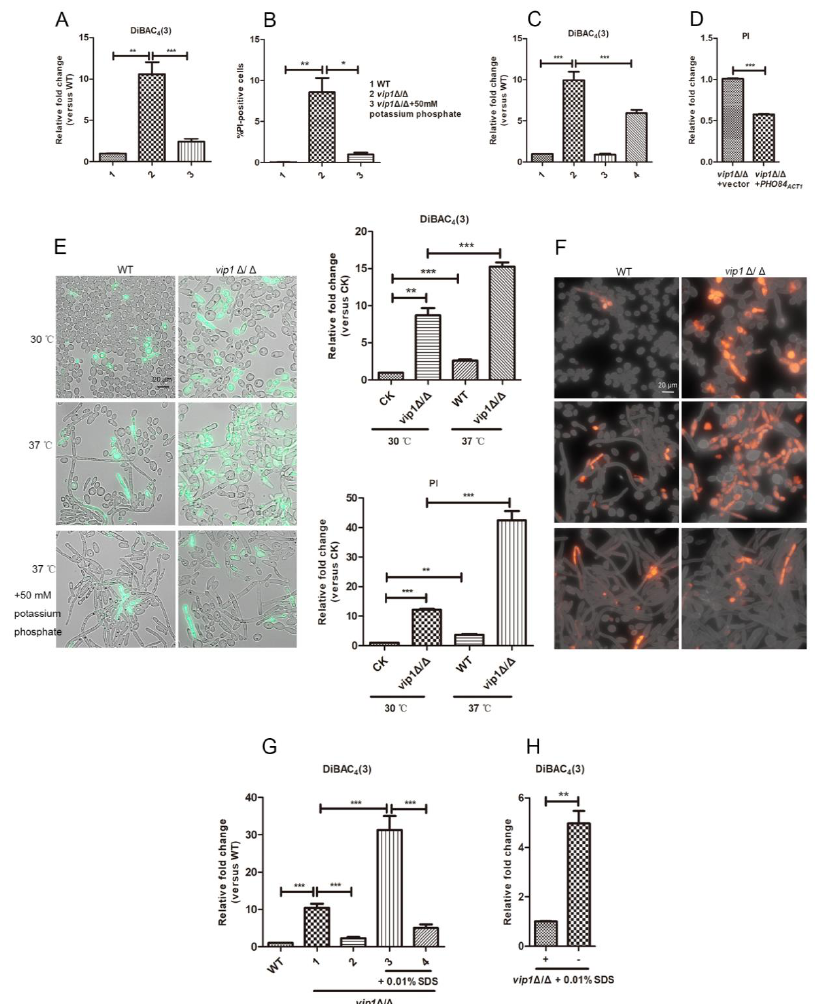
Figure 4. The addition of Pi helps to alleviate the membrane damage of vip1 ∆ / ∆ . Adding Pi can reduce the membrane potentials ( A ) and permeabilities ( B ) of vip1 ∆ / ∆ . ( A , B ) 1 and 2: WT or vip1 ∆ / ∆ strains grown in SC, 3: vip1 ∆ / ∆ strains grown in SC supplemented with Pi. ( C ) Overexpression of PHO84 reduced the membrane potential of vip1 ∆ / ∆ . 1–4: WT+vector, vip1 ∆ / ∆ +vector, WT+ PHO84 ACT1 , vip1 ∆ / ∆ + PHO84 ACT1 . ( D ) Overexpression of PHO84 can reduce the membrane permeabilities of vip1 ∆ / ∆ . The addition of Pi can reduce the membrane potentials ( E ) and permeabilities ( F ) of vip1 ∆ / ∆ under stimulation at 37 ◦ C. ( E , F ) The strain was grown in SC or SC medium supplemented with Pi at 30 or 37 ◦ C. Cell staining was performed, and the fluorescence was observed with a microscope or the fluorescence intensity was measured with a microplate reader. CK: WT strains grown in SC at 30 ◦ C. ( G ) Pi supple- mentation reduced the degree of membrane damage in vip1 ∆ / ∆ strains when stimulated by SDS. WT: WT was grown in SC for 2 days; 1: vip1 ∆ / ∆ was grown in SC for 2 days; 2: vip1 ∆ / ∆ was grown in SC with Pi for 2 days; 3: vip1 ∆ / ∆ was grown in SC for 1 day, then treated with 0.01% SDS and allowed to grow for 1 day; 4: vip1 ∆ / ∆ was grown in SC with Pi for 1 day, then treated with 0.01% SDS and allowed to grow for 1 day. The strain was collected, and DiBAC 4 (3) staining was used to measure the membrane potentials. ( H ) The vip1 ∆ / ∆ strain that grew to the stationary phase was treated with Pi, and the strain’s resistance to SDS was enhanced. +: vip1 ∆ / ∆ was grown in SC for 1 day, treated with Pi directly and allowed to grow for 1 day. Then, 0.01% SDS was added for another day, and the strains were collected to measure the cell membrane potential. -: vip1 ∆ / ∆ was grown in SC for 2 days, treated with 0.01% SDS, grown for another day and collected to determine the cell membrane potential. ( A – H ) The strain fluorescence intensity was measured with a microplate reader (Perkin Elmer, USA). * p < 0.05, ** p < 0.01, *** p <